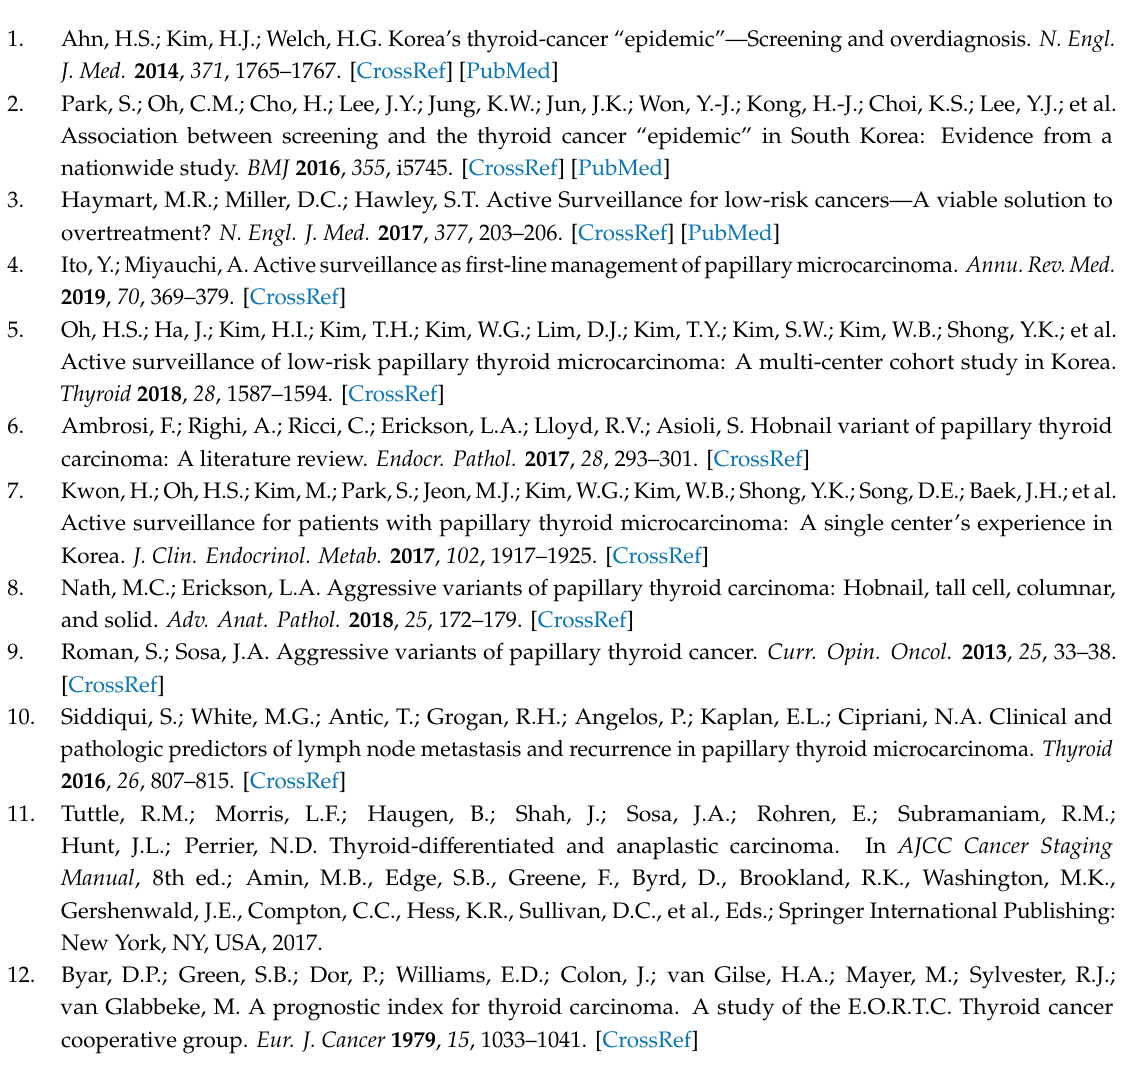
Figure S1: Di ff erences in expression of E-cadherin and vimentin among PTC; Figure S2: Correlation of mRNA expression level between TUBB3 and epithelial–mesenchymal transition (EMT)-related markers; Table S1: Di ff erential TUBB3 and E-cadherin expression among thyroid